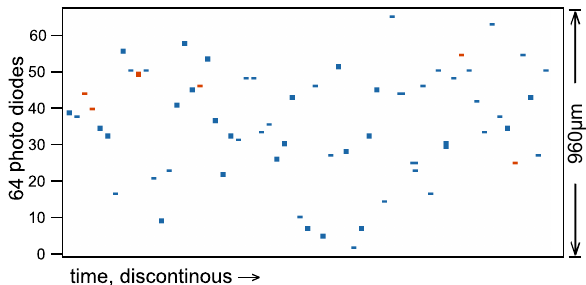
Figure 14. Example of the 62 CIP grayscale single cloud particle images, shown here as blue or red square elements, recorded over about 30min during a flight on 25 January 2010 in the PSC field where FSSP-100 detected significant numbers of particles larger than 10µm (see also Table 1). The pixel size of the CIPgs (i.e., the object distance of photo-diodes on the array) is 15µm. Most of the pixels where triggered by the first shadow threshold at 35% (blue). The second threshold at 50% (red) only accounts for less than a tenth of detected events. These image blotches can be considered visual proof for the existence of NAT-rock-sized PSC particles. Table 1. Numbers of particles (with size diameters D p above the in- dicated values) measured by the FSSP-100 compared to the number of CIPgs images detected in PSCs.